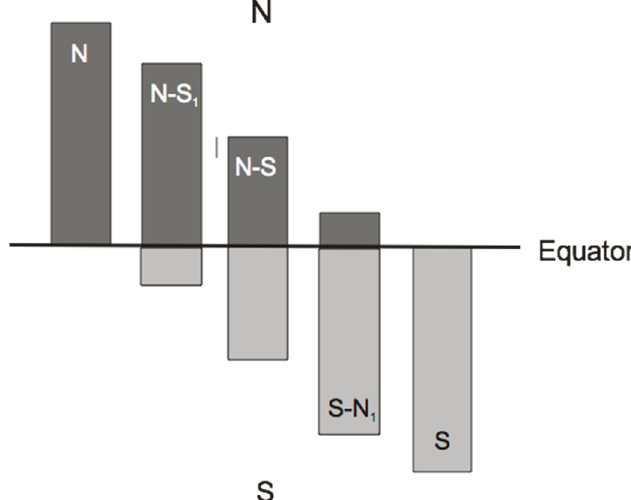
Figure 8. Occurrence of species from particular genera on both hemispheres: N—only in northern hemisphere, N-S 1 —mainly in northern hemisphere, N-S—with the same rate in both hemispheres, S-N 1 —with prevailance in southern hemisphere, S—only in southern hemisphere.